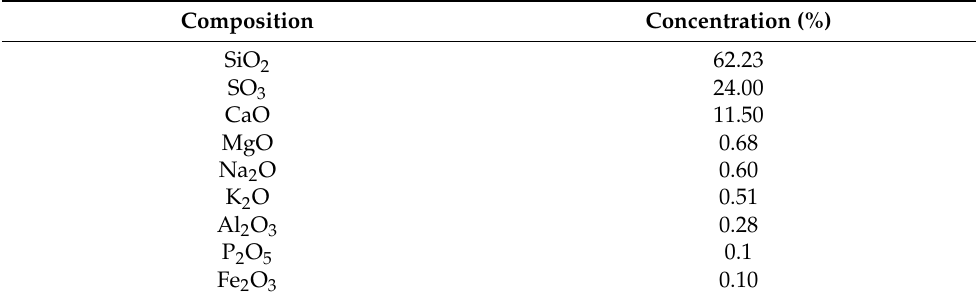
Figure 5. Optimization of the model obtained by desirability function. Table 4. X-ray fluorescence analysis of sugarcane